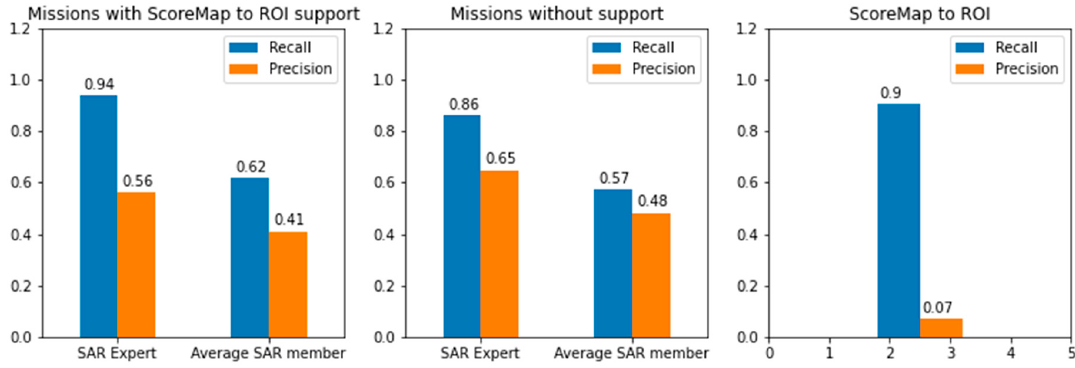
Figure 22. Comparison of the recall achieved by the qualified SAR experts compared to the average SAR member. SAR